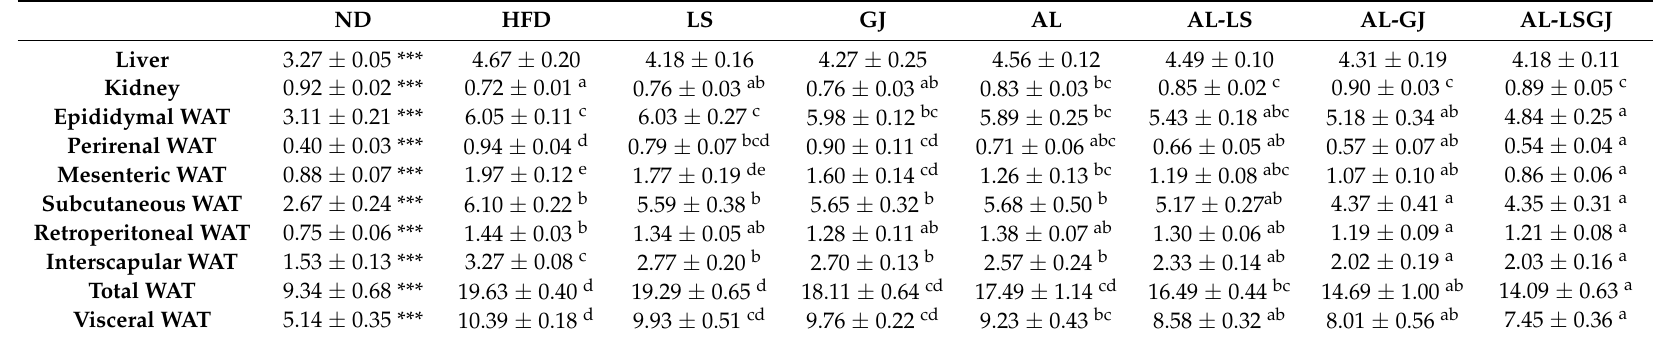
Table 3. Effect of synbiotic supplementation for 12 weeks on organ and white adipose tissue weights.